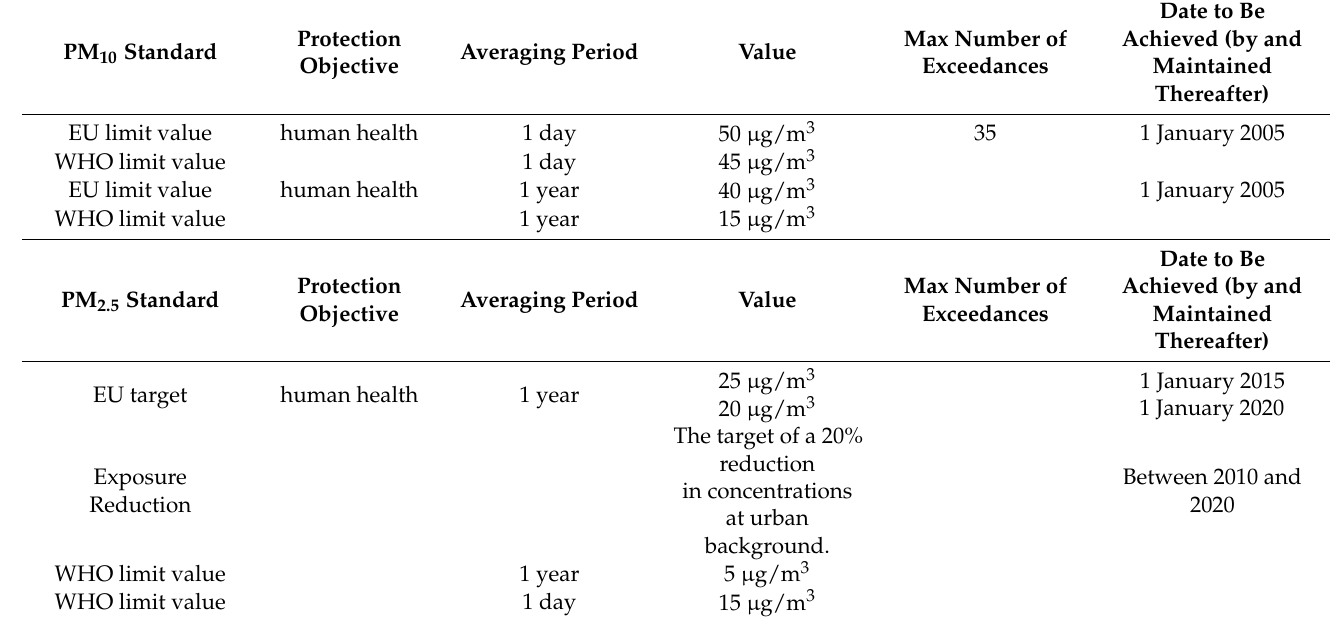
Table 1. EU and WHO limit values for PM 10 and PM 2.5